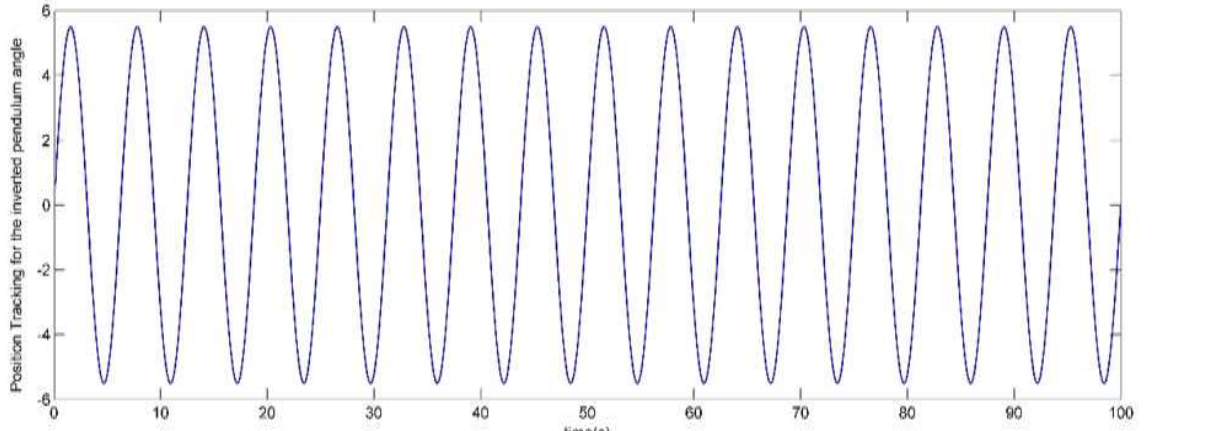
Figure 6. The position tracking vs. time for the pendulum angle (blue dashed line is the reference signal, the solid blue line is the output signal and the red dashed line is for the AFHSMC